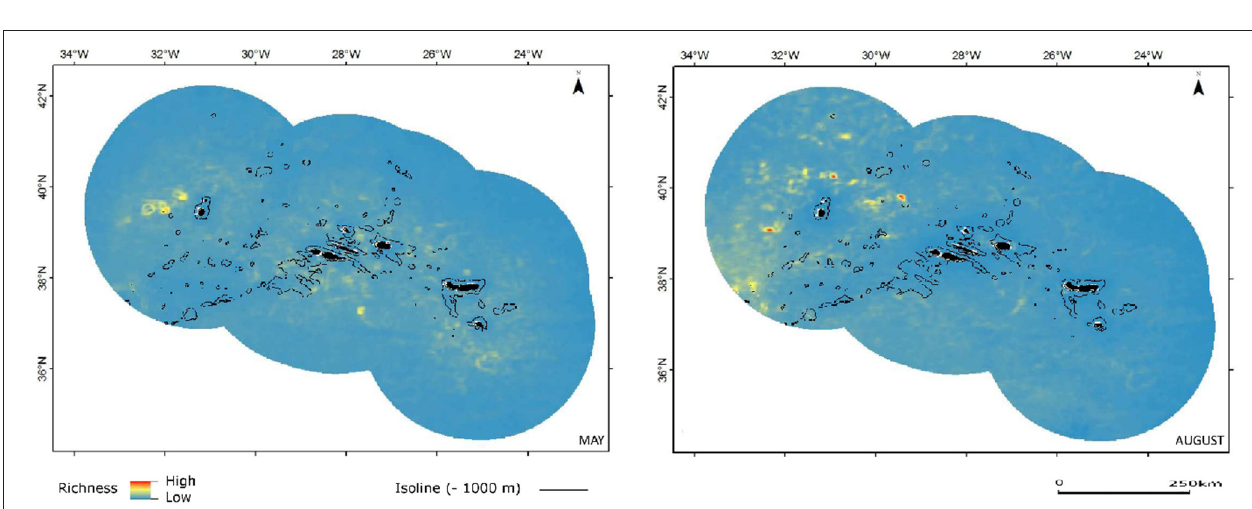
FIGURE 6 | Combined predicted richness of large dolphins in spring (May) and summer (August). Color scheme as in Figure 3 .